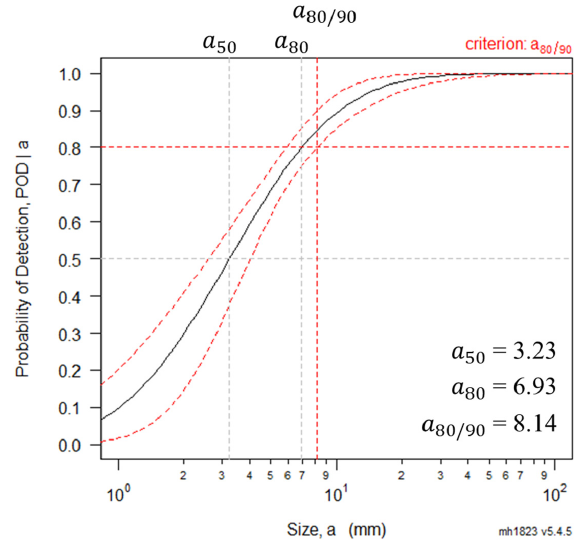
Figure 2. POD analysis results for the tube weld specimens. Table 5. POD analysis results of each team for the detectable length with 80% probability [mm]. In the graph, the black line indicates the POD according to the flaw length, and the red dotted line indicates the 90% confidence interval. The POD analysis results indicated Team All that 𝑎 (cid:2873)(cid:2868) was 3.23 mm and 𝑎 (cid:2876)(cid:2868) was 6.93 mm for flaw detection. Here, 𝑎 (cid:2873)(cid:2868) represents the minimum flaw length at which the flaws can be detected with 50% probability. In addi- tion, the value of 𝑎 (cid:2876)(cid:2868)/(cid:2877)(cid:2868) representing the 90% confidence interval exhibited a large error teams. A POD analysis was performed for each team, and the results are presented in Table 5. For 𝑎 (cid:2876)(cid:2868) , the teams with the best and worst performance obtained values of 5.59